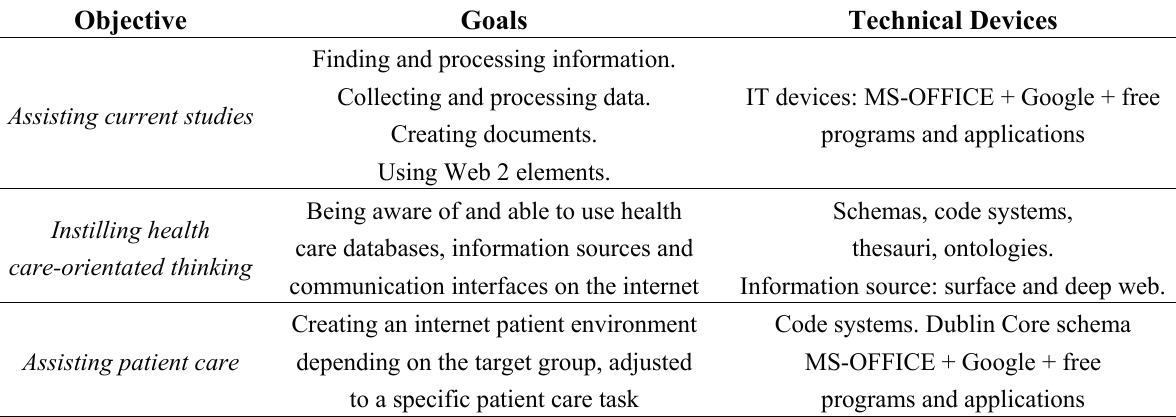
Table 1. Educational levels corresponding to given